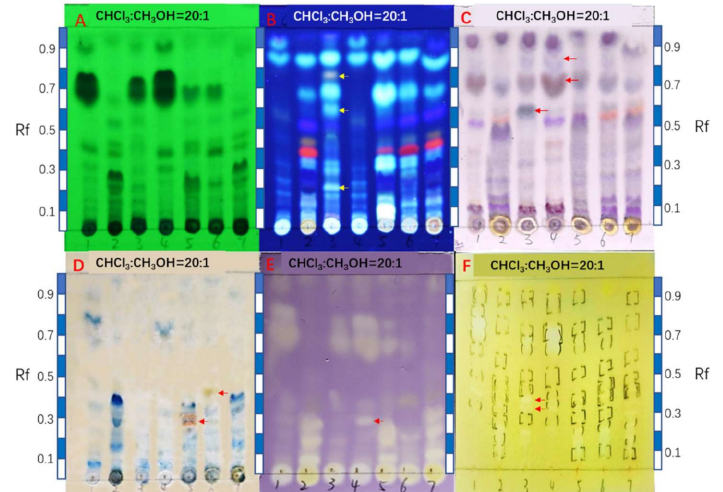
Figure 2. HPTLC fingerprints of the axenic and co-cultural extracts. ( A ) is the UV images of ex- periments G1–G7 under 254 nm (the sample numbers were marked with pencil below the starting line). ( B ) is the UV images of G1–G7 under 365 nm. ( C ) is the image of sulfuric acid-anisaldehyde colorized plate of G1–G7. ( D ) is the image of potassium ferricyanide-ferric chloride (PFFC) col- orized plate of G1–G7. ( E ) is the DPPH free radical scavenging autographic image of G1–G7. ( F ) is acetylcholinesterase inhibitory bioautographic image of G1–G7. The developing agent was chloroform:methanol = 20:1 ( v / v ). The rulers beside the TLC plate are taken as references for Rf value calculation. The yellow or red arrows mark the new metabolites produced only under co-cultural